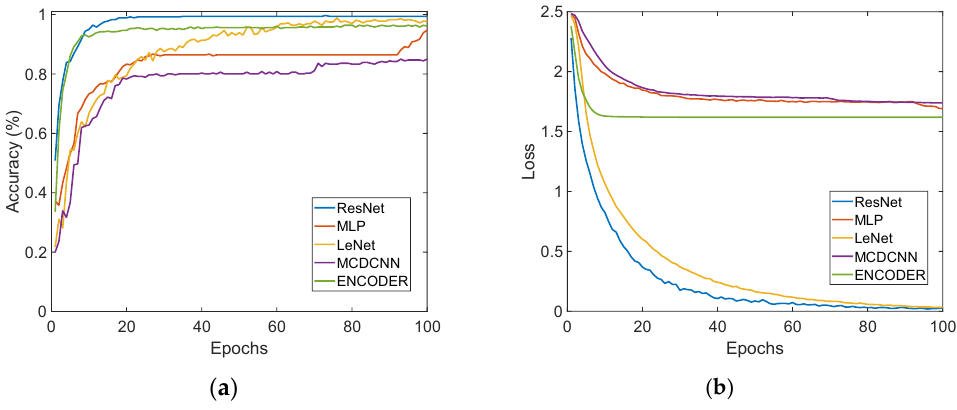
Figure 13. Learning curves of the five models based on the 12 object types. ( a ) Learning curves of the five models. ( b ) Loss values of the five models.